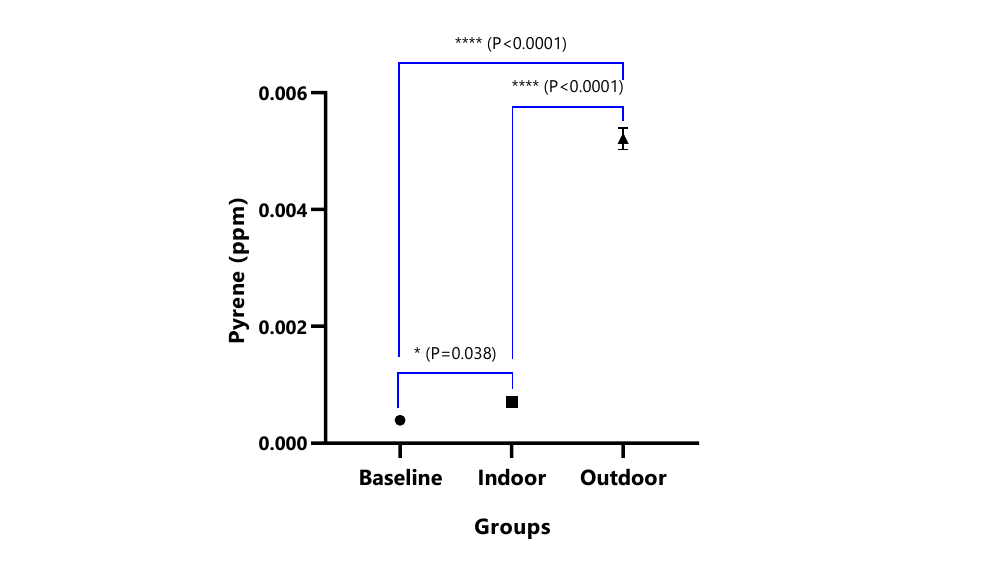
Figure 9. The mean concentrations and test of mean difference for ( A ) Indeno (1 2 3-cd) pyrene and ( B ) Phenanthrene in the various animal groups.